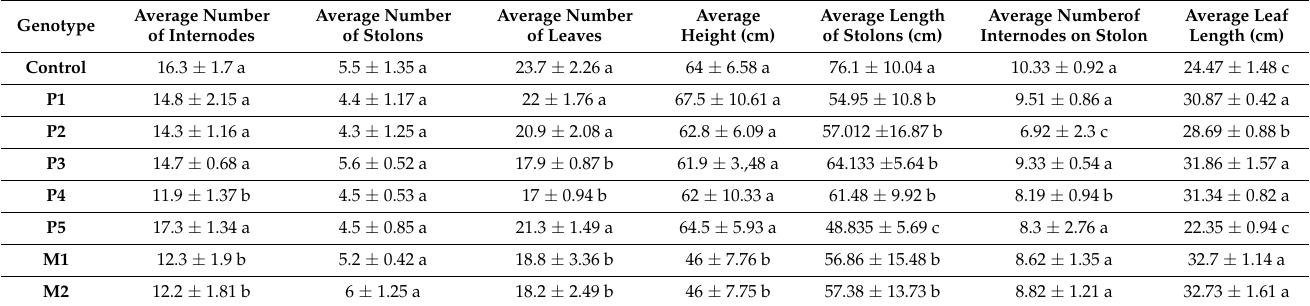
Table 2. Morphological characteristics of diploid, mixoploid, and autotetraploid plants cultivated in a greenhouse.